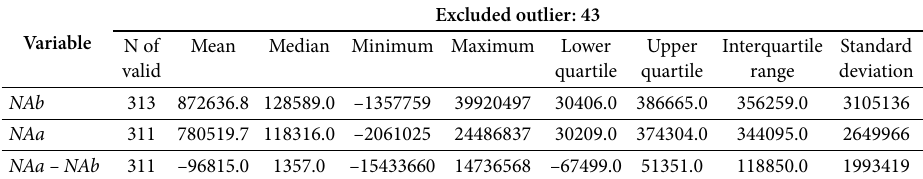
Table 2. Descriptive statistics of the net assets sample